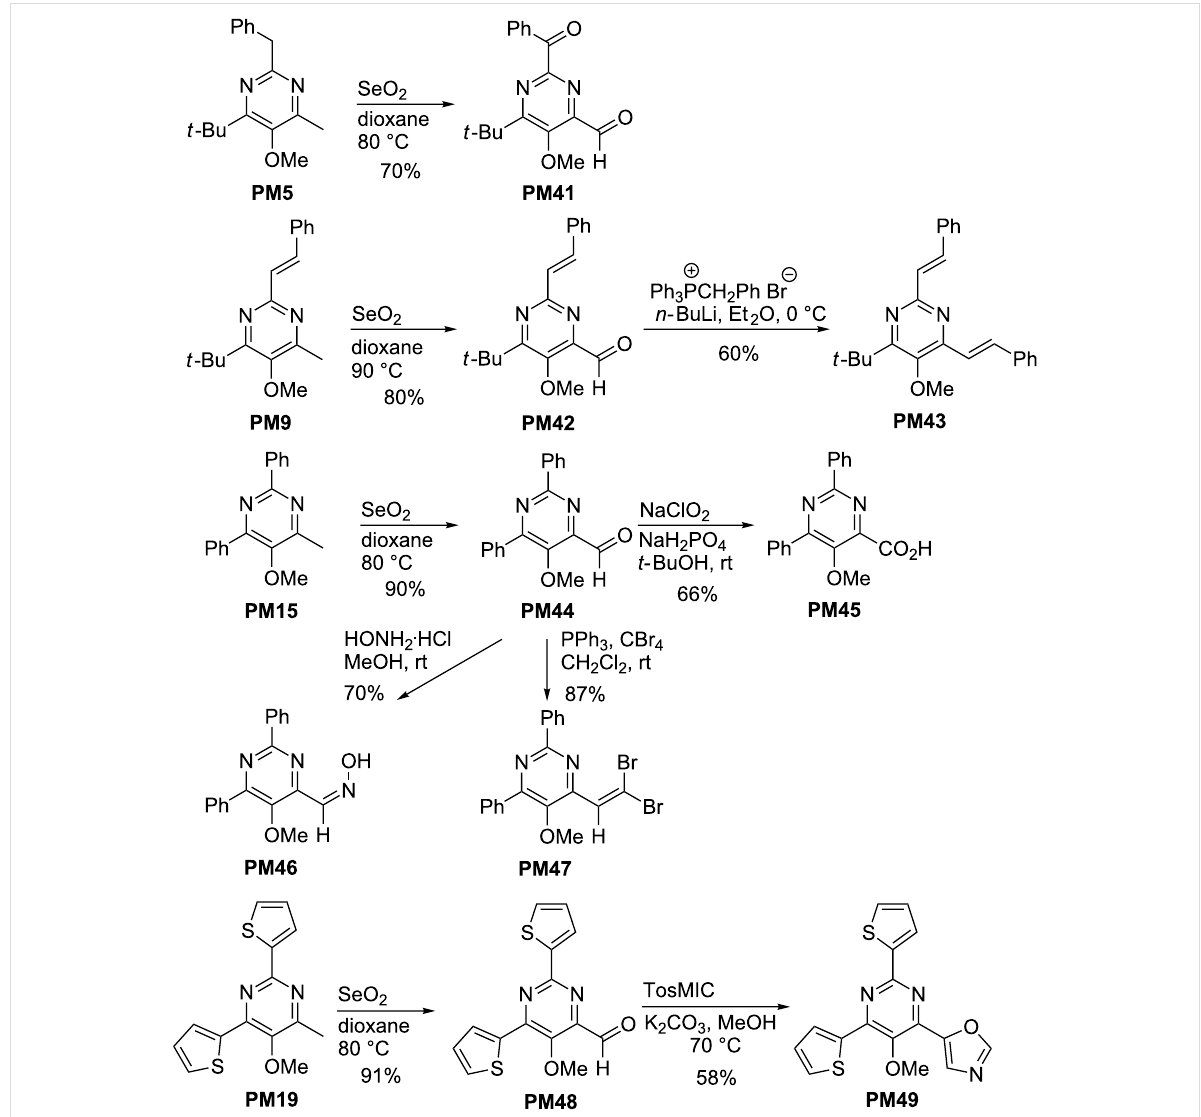
Scheme 11: Functionalization of pyrimidine derivatives PM through selenium dioxide oxidations of PM5 , PM9 , PM15 and PM19 leading to 4-formyl- substituted pyrimidines PM41 , PM42 , PM44 and PM48 and selected subsequent transformations (TosMIC = tosylmethyl